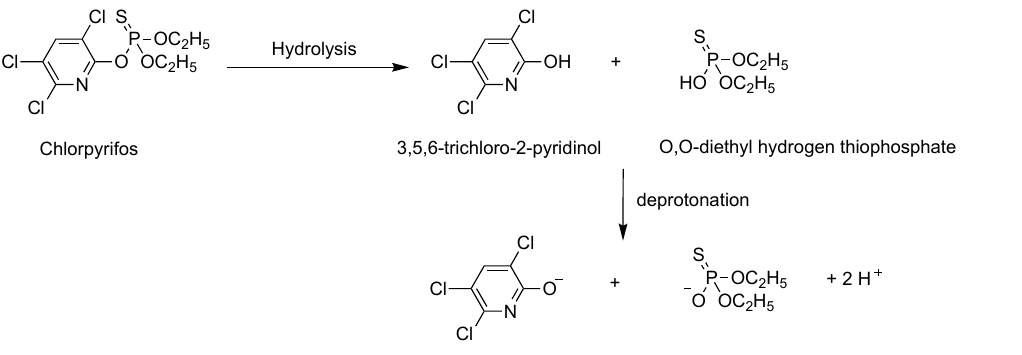
Figure 8. Hydrolysis of chlorpyrifos leading to 3,4,5-trichloro-2-pyrinol and O,O-diethyl hydrogen thiophosphate. These two molecules are weak acids which can lead to the formation of their corresponding base in water.